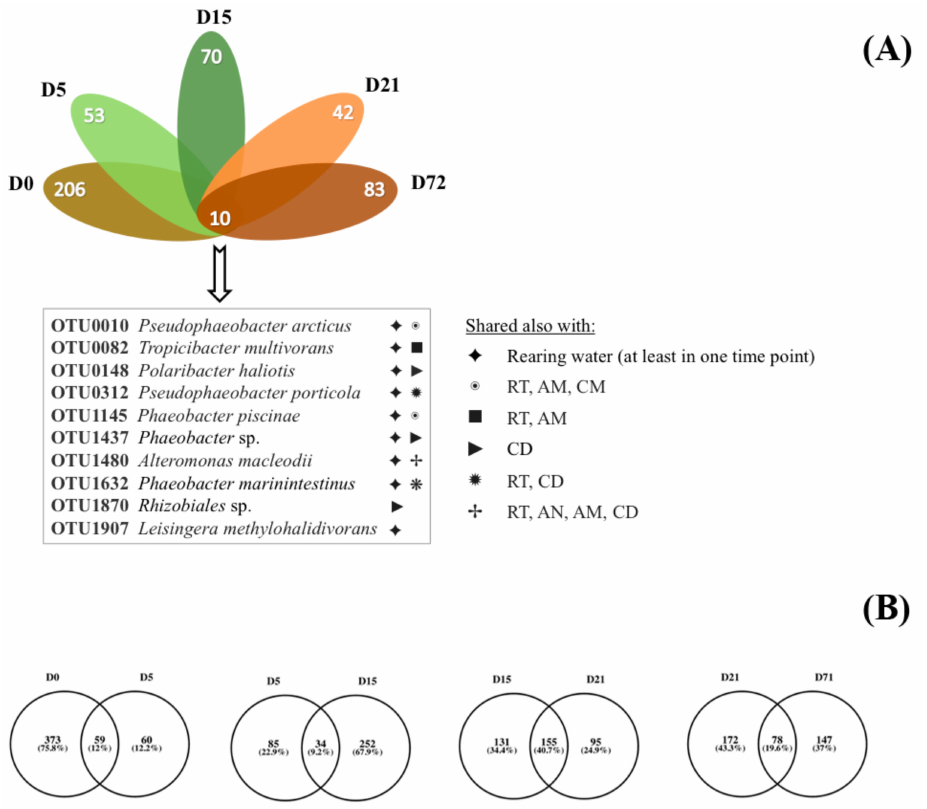
Figure 4. Flower diagram ( A ) of the shared and unique ( B ) operational taxonomic units (OTU) in Sparus aurata larvae from day (D) zero to day 71. AM: Artemia salina metanauplii, AN: Artemia salina nauplii, CD: Commercial diet, RT: